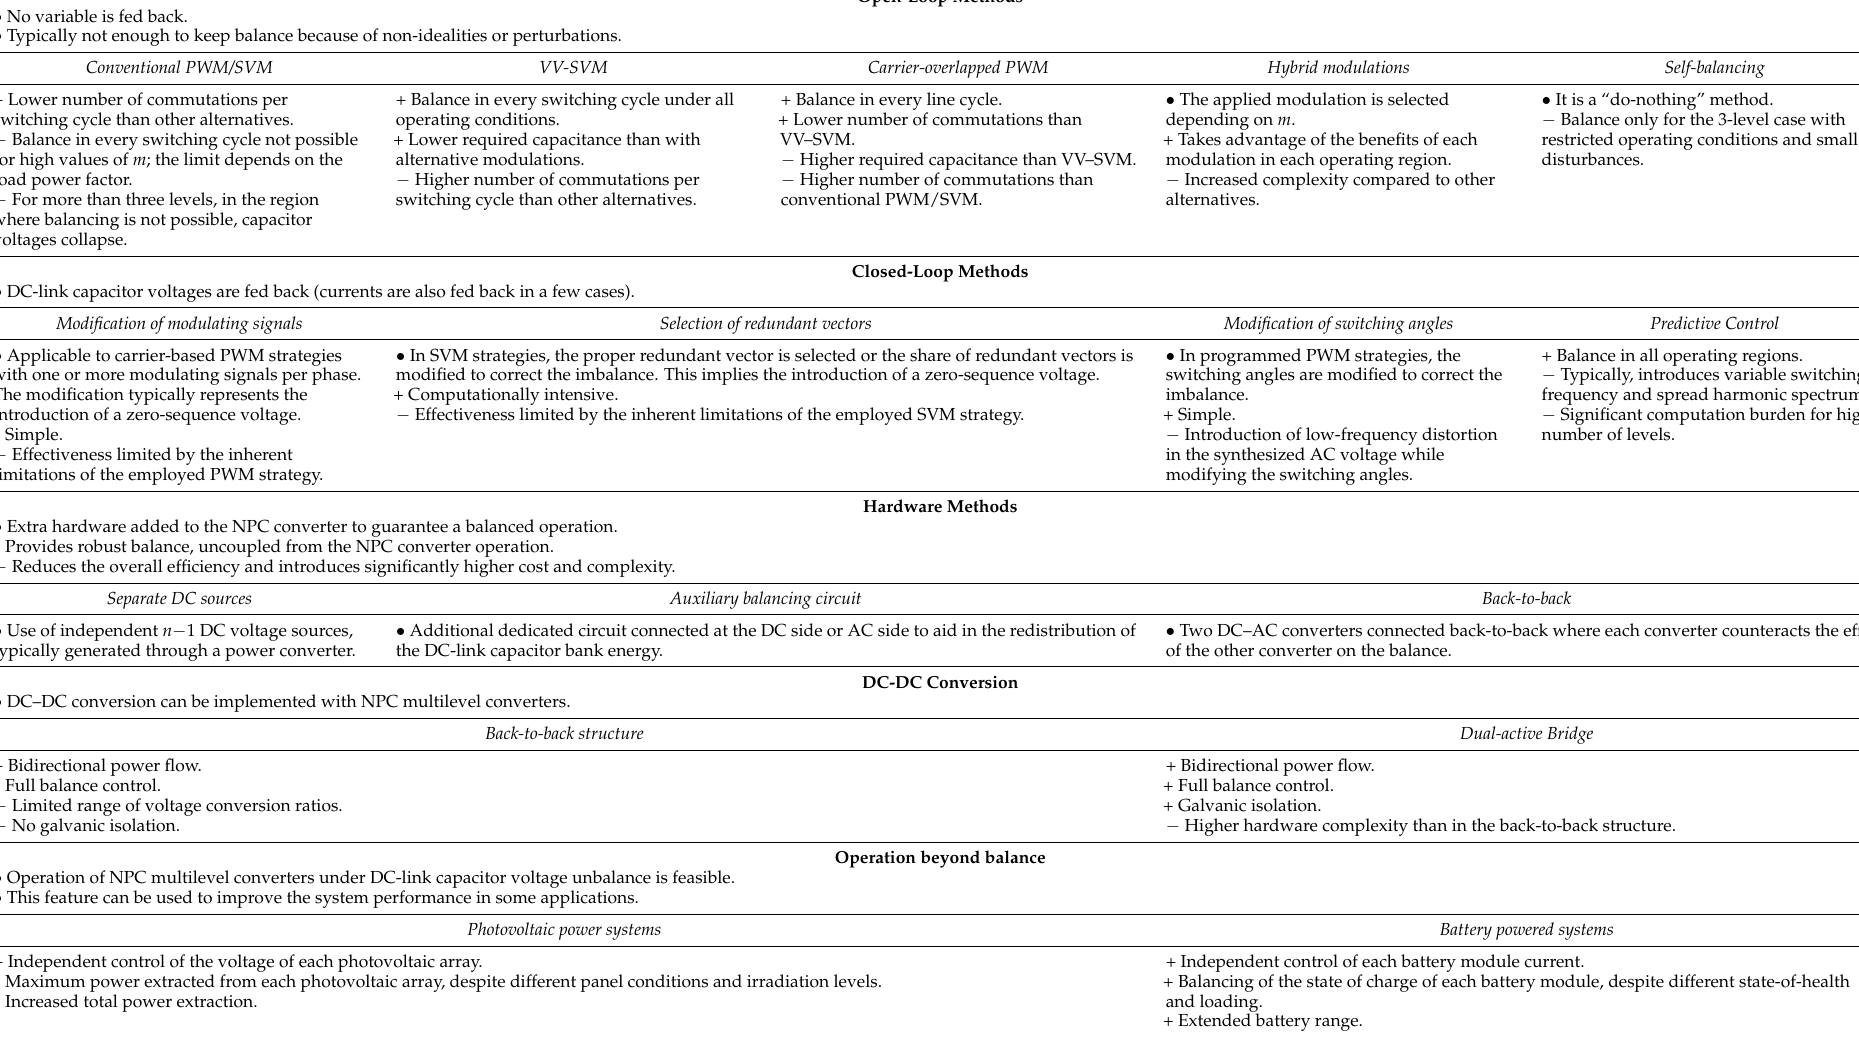
Table 1. Summary of